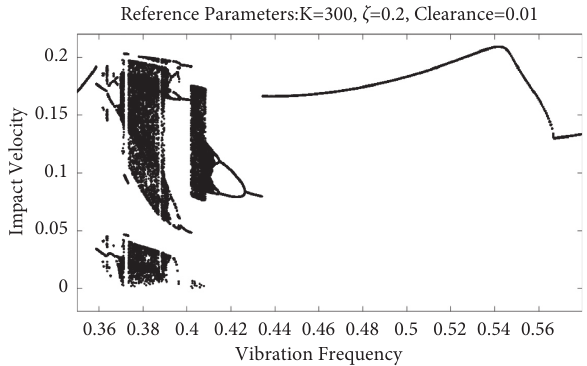
Figure 4: System bifurcation